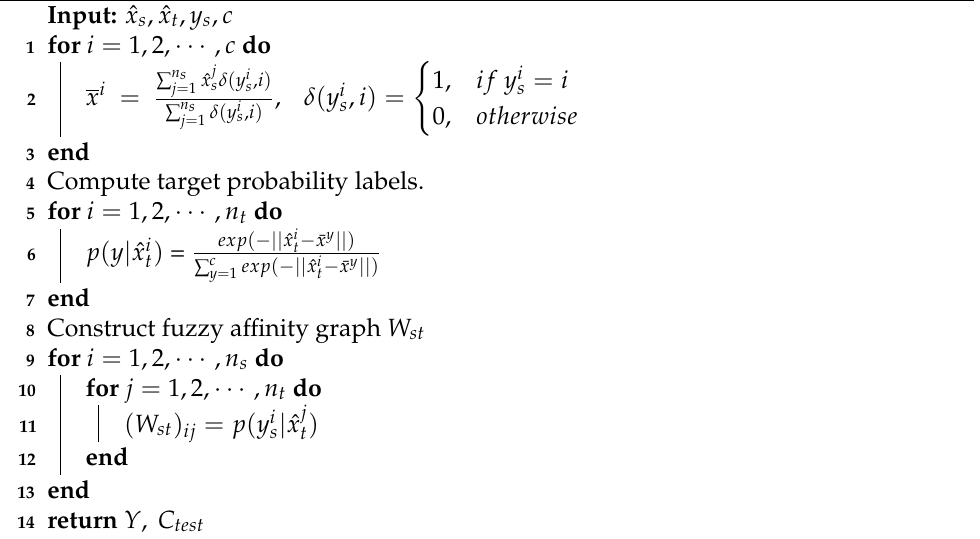
Algorithm 1: Cross-domain affinity graph ( W st )